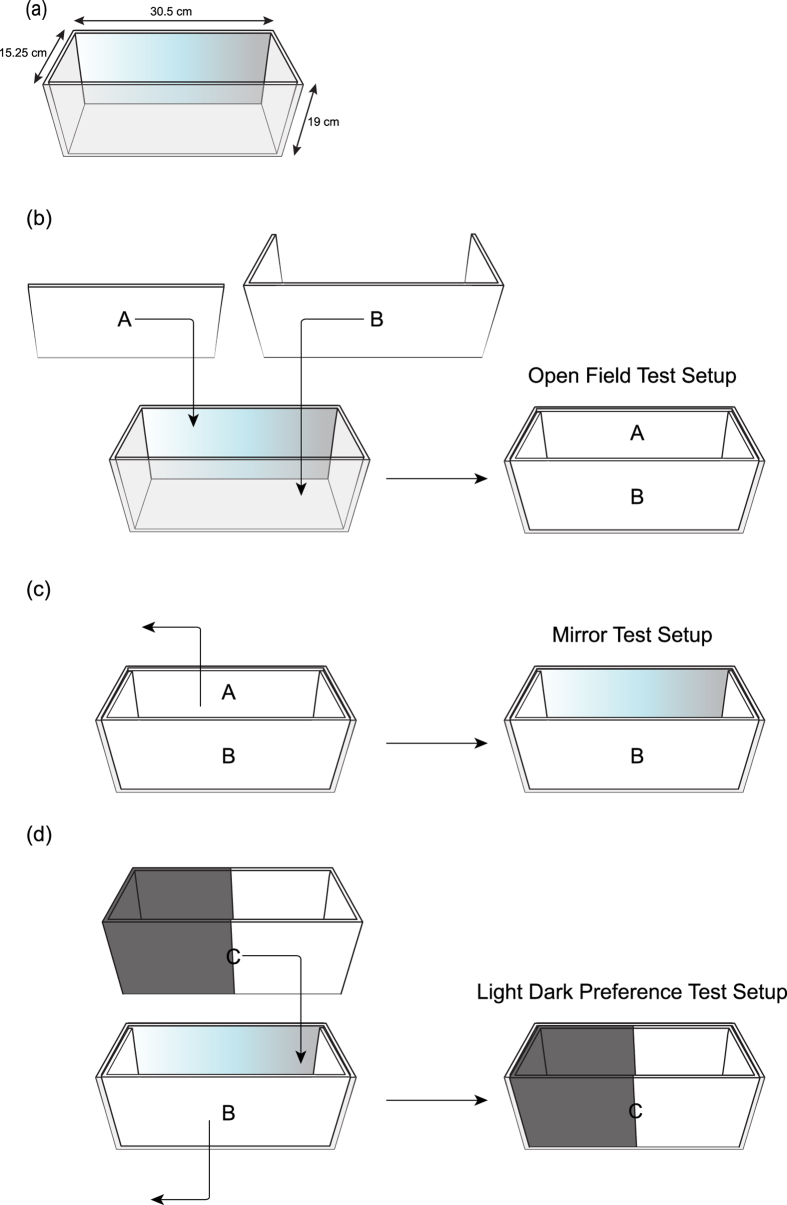
Diagrammatic representation of the aquaria(a) and panels (A–C) that were used to create the open field test (b), mirror approach test (c), and light/dark test (d).Blurred panels indicate the mirrors. Thin arrows indicate placement or removal of wall panels. Dimensions of zones used for quantification in Ethovision are also shown.